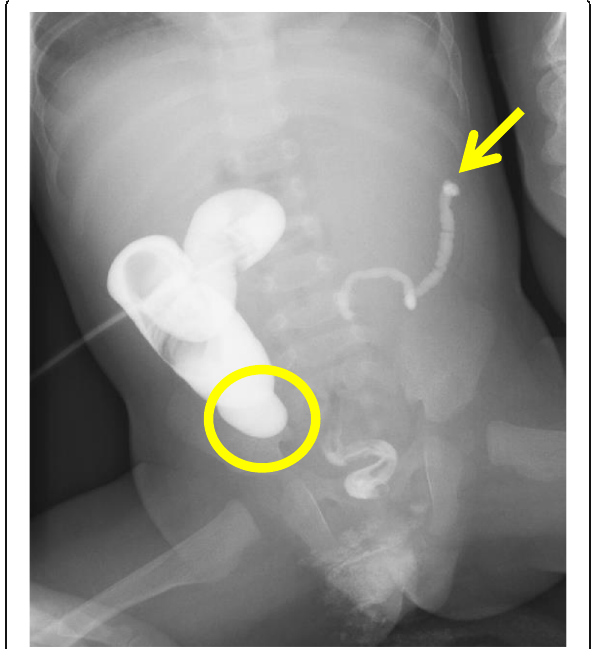
Fig. 3 Preoperative contrast enema examination (7 months of